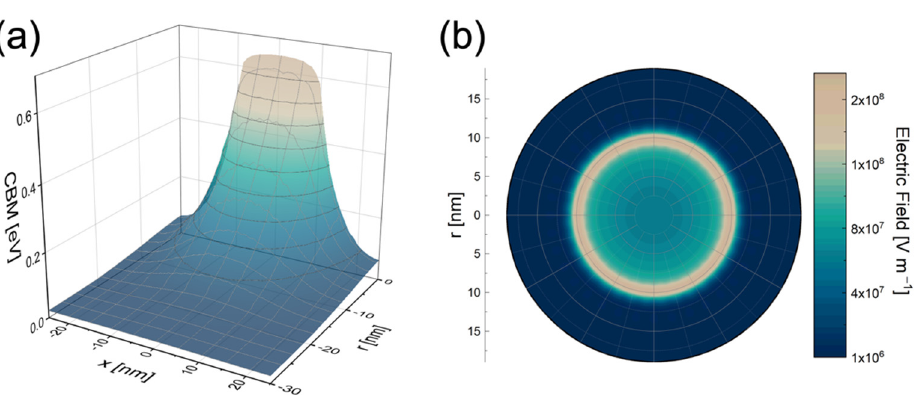
Figure 5. COMSOL simulations at the interface between Au and ZnO NR. ( a ) 3D plot showing CBM energy and ( b ) electric field map in ZnO 5 nm below a circular Au dot.